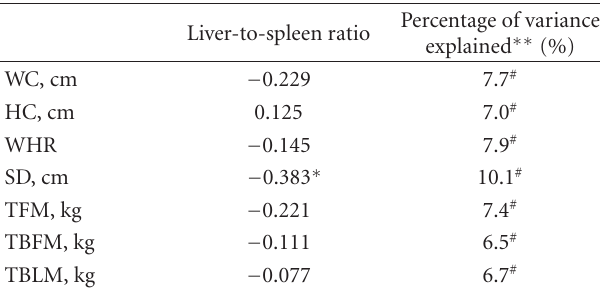
studied variables. ∗∗ Variance explained by age, BMI, and the studied variable. #